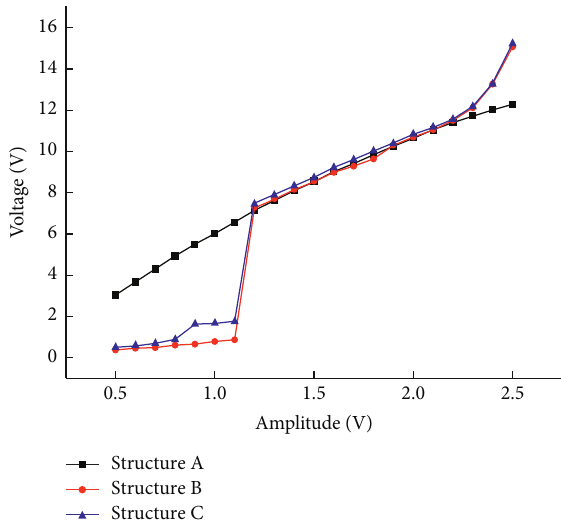
Figure 13: Relation of the voltage-amplitude of three structures is given when magnetic distances of the structure B and the structure C are both 14mm.